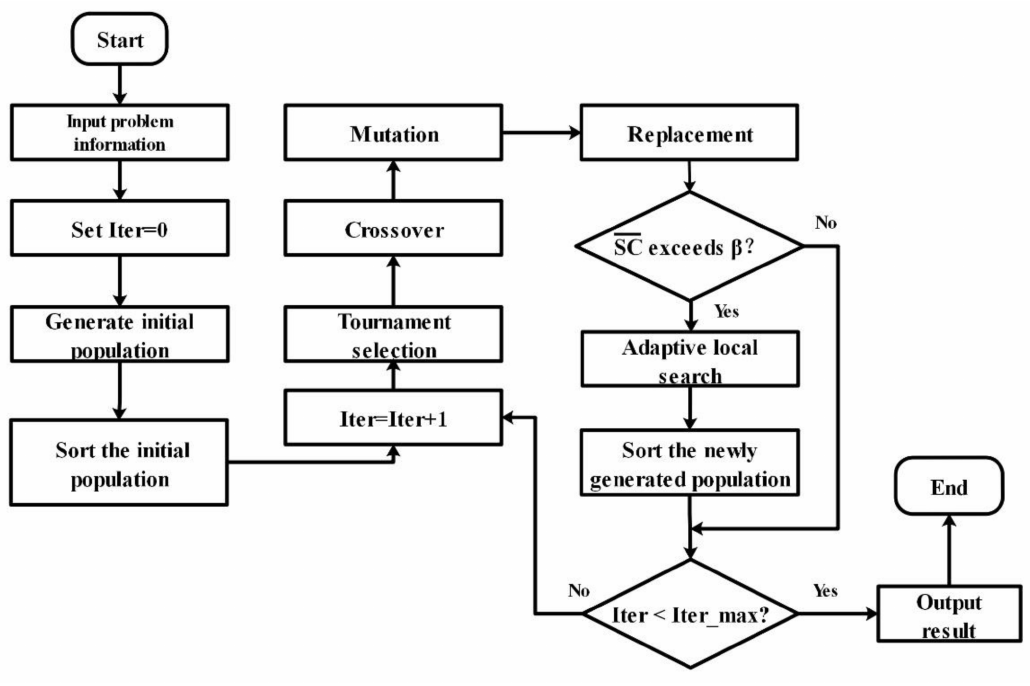
Figure 4. Flowchart of our algorithm.